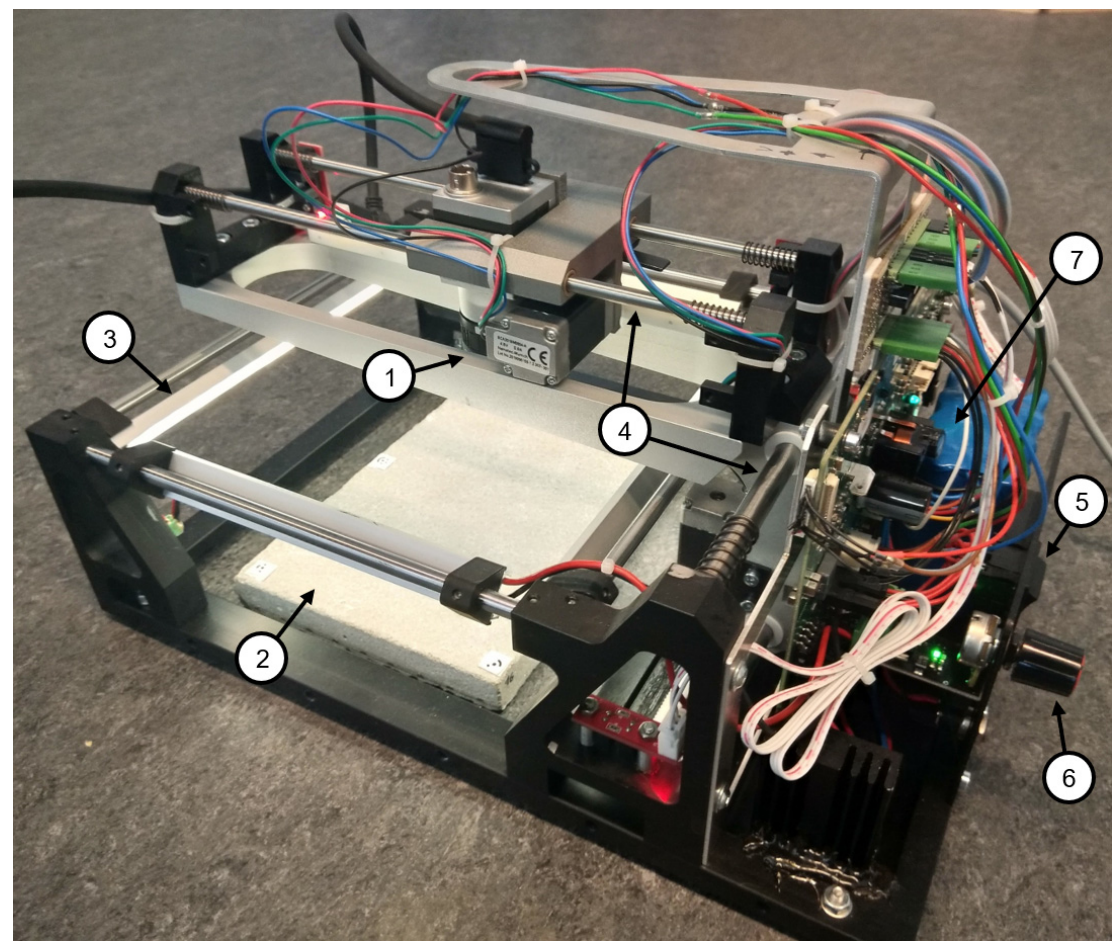
Figure 6. Camera-based measurement system. 1—Industrial camera; 2—concrete specimen; 3—one of the four LED strips; 4—both moving axes; 5—power switch; 6—rotary switch for illumination adjustment; 7—rechargeable battery.